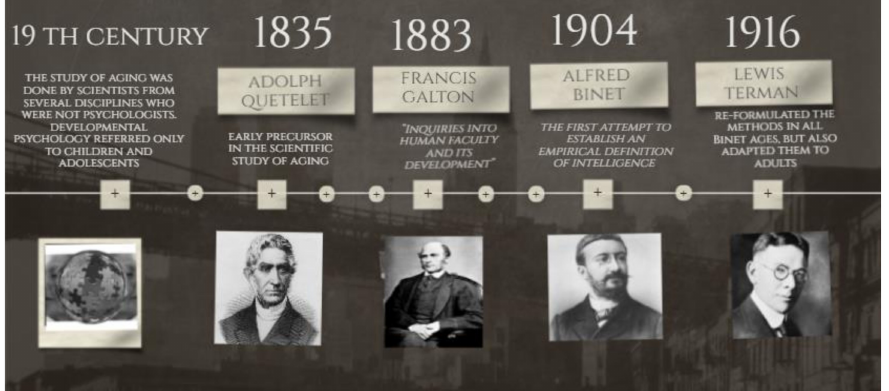
Figure 1. Main historical antecedents in the study of